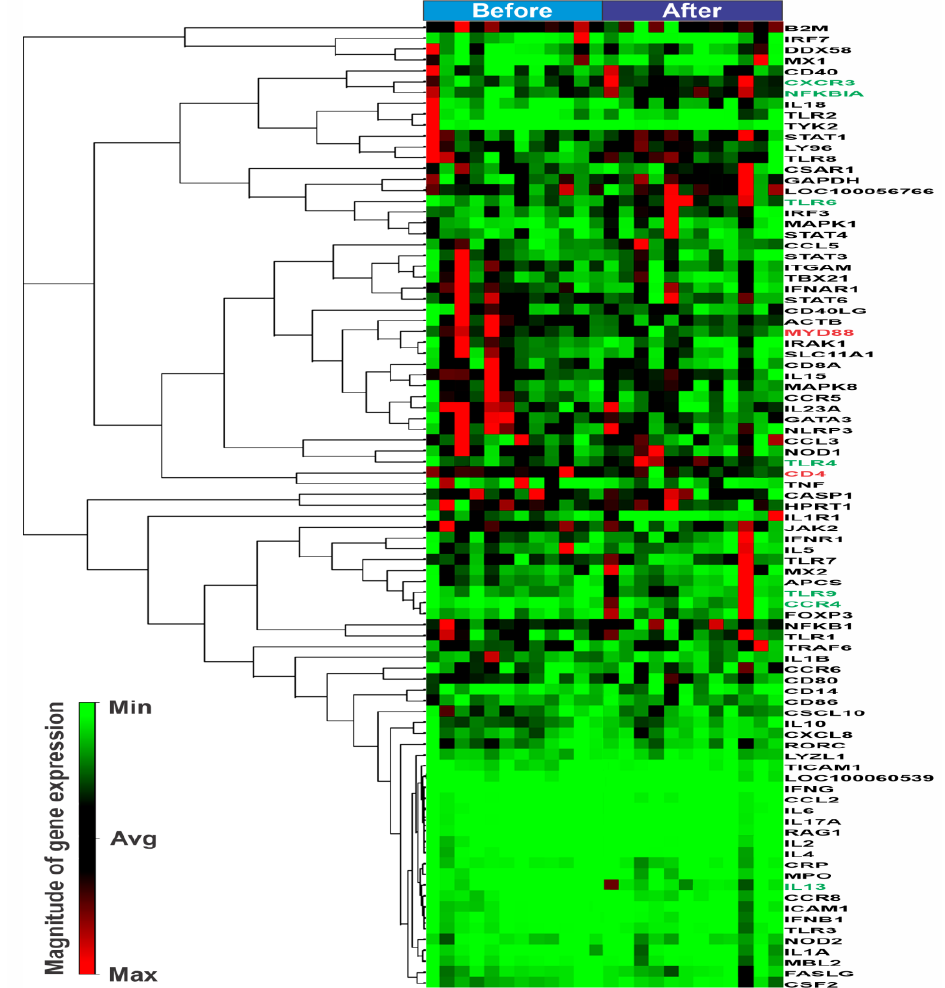
Figure 1. A heatmap of the expression of innate and adaptative immune genes in horses before and after a competition. The differences among the individuals and states (before and after the competition) are shown by differences in color according to the scale for higher (red) or lower (green) gene expression.